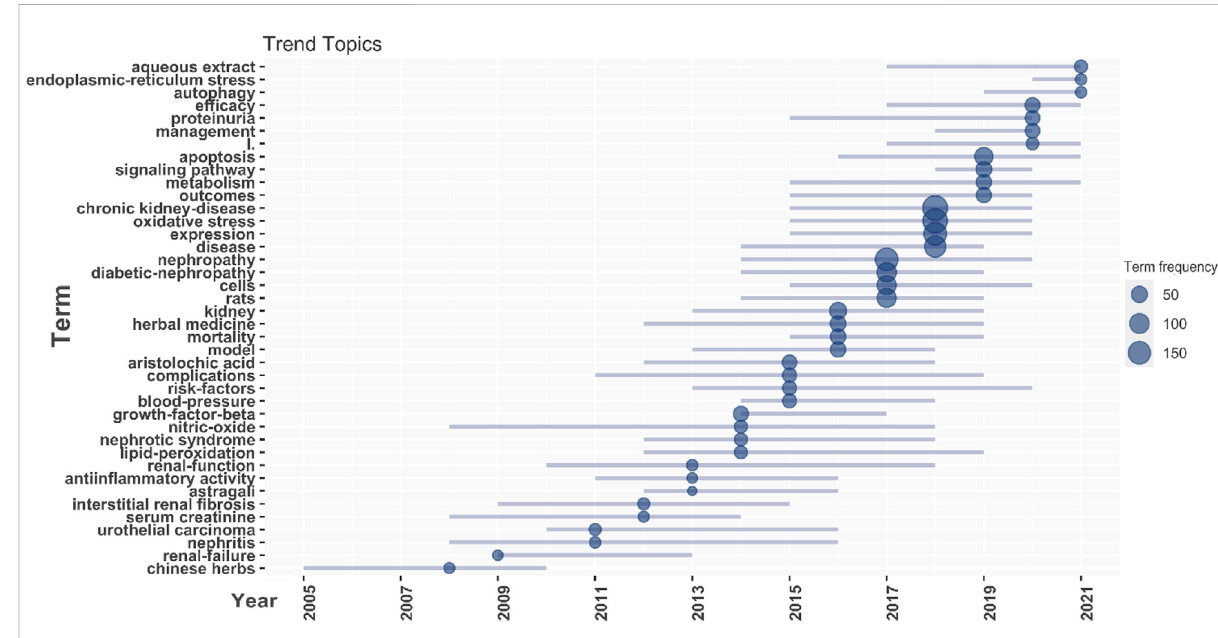
FIGURE 7 Frequency of keywords occurrence over time in the topic of herbal medicine to control CKD.